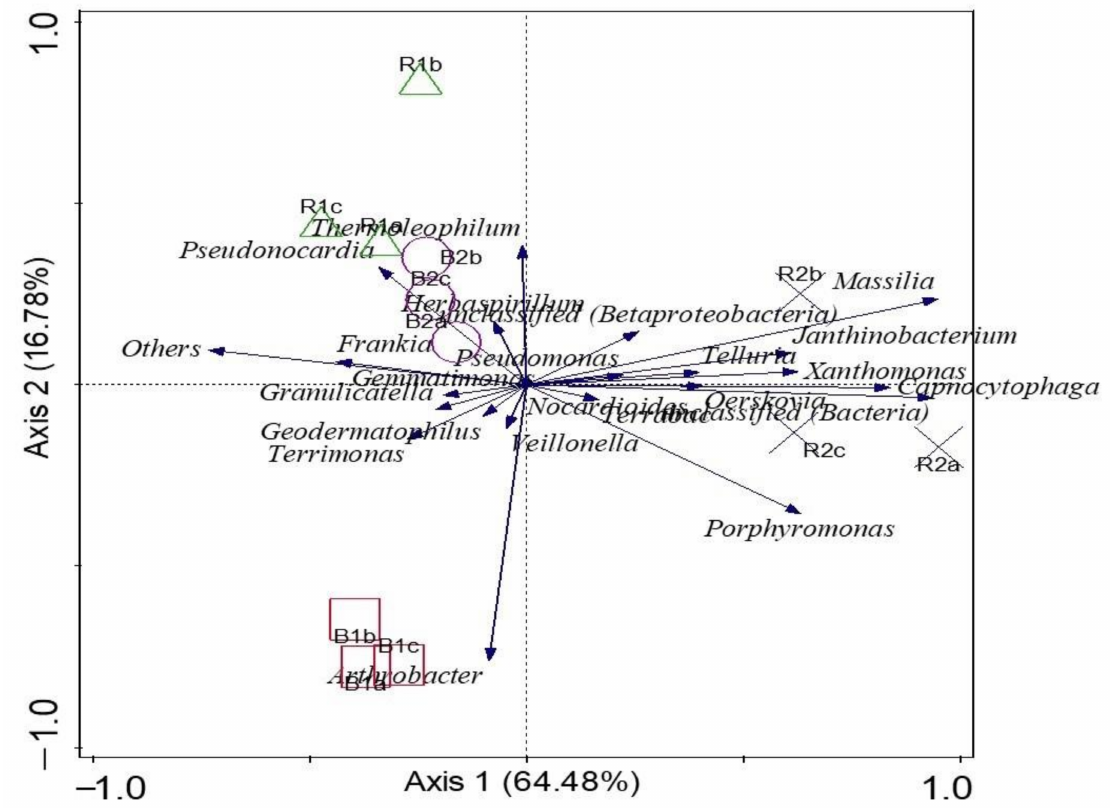
Figure 6. PCA of microorganisms RDP (ribosomal database project) classifier at the genus level. The length of the vectors reveals the strength of influence of the microorganisms at both rhizosphere and the bulk soil sample. Table 3. Diversity indices of the functional genes observed in our R1, R2, B1, B2 metagenomes. R1 R2 B1 B2 p